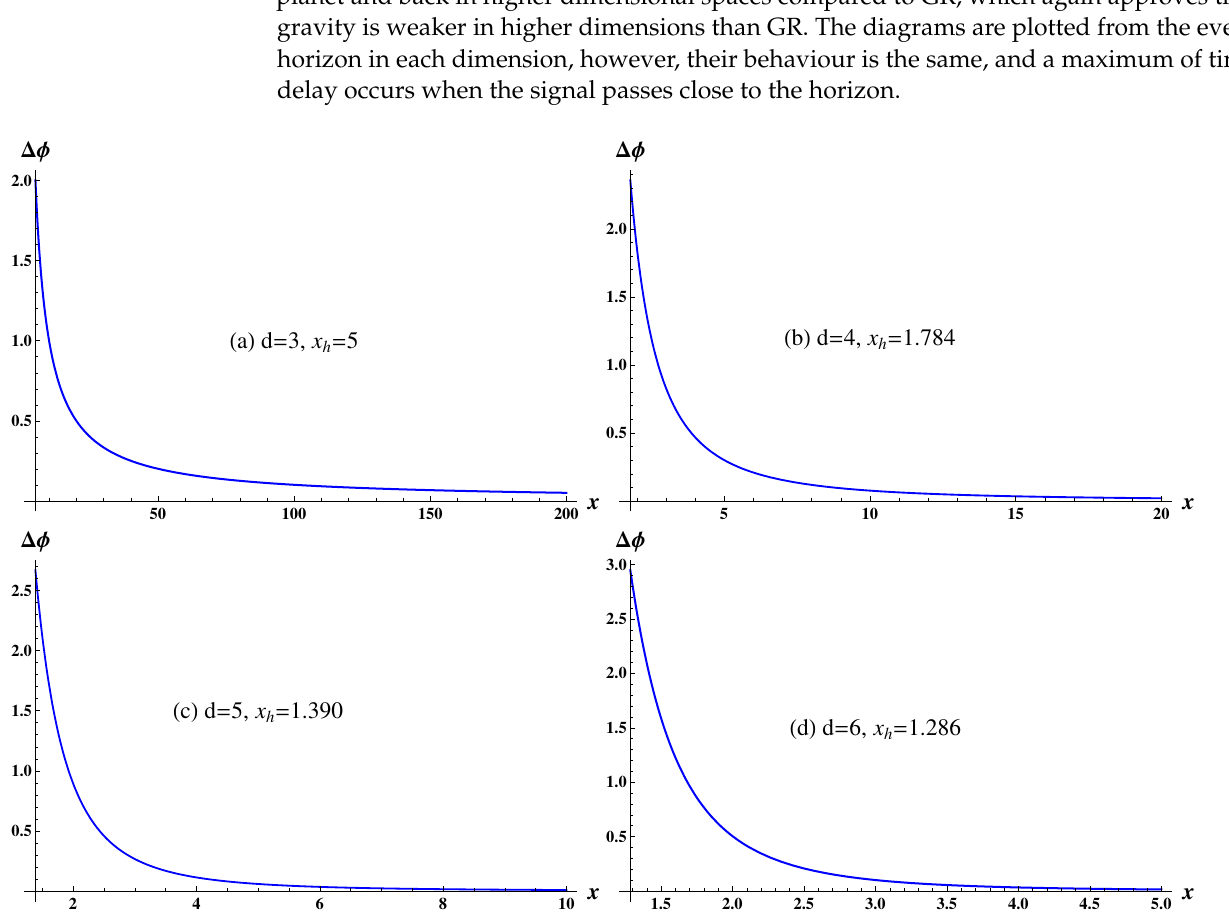
Figure 4. Deflection of light around a Schwarzschild black hole for α = 1.5 and η = 2.5 in diffenet spacetime dimensions.